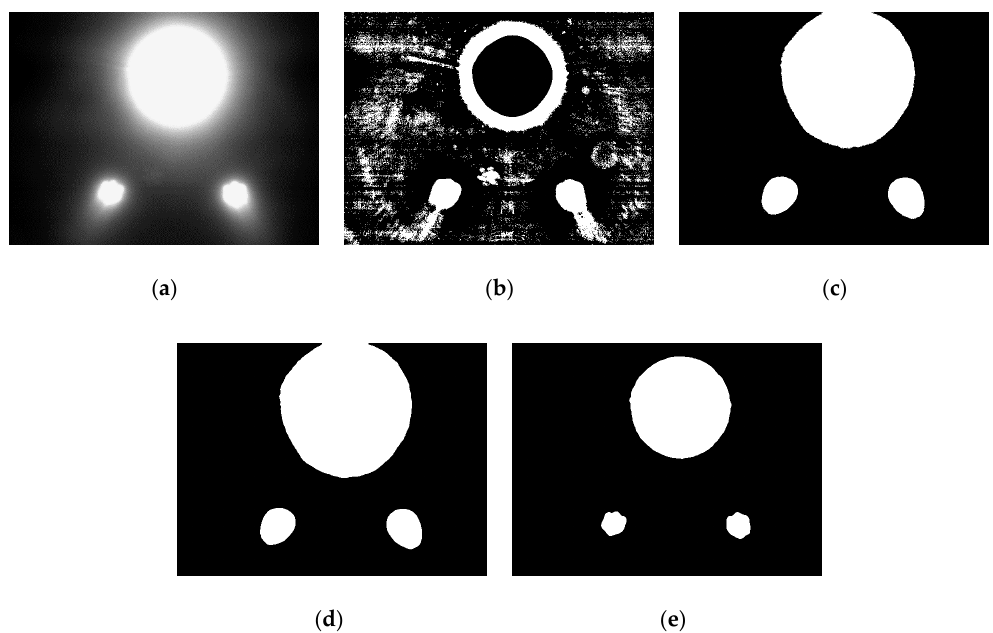
Figure 8. The threshold segmentation results for image captured near the station: ( a ) The original image; ( b ) Adaptive local TSM; ( c ) Pre-specified TSM, set T as 125; ( d ) Traditional OTSU TSM, T = 130; ( e ) Adaptively weighted OTSU TSM, T = 235.